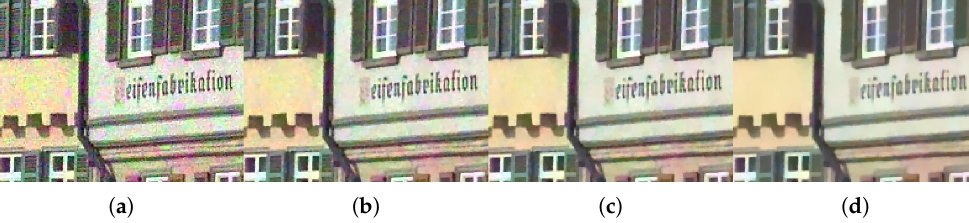
Figure 9. Influence of regularization parameter λ 1 for test image House for crosstalk degradation 2 (crosstalk kernel with σ g = 0.6 and noise with σ n = 0.04): ( a ) λ 1 = 0.01, ( b ) λ 1 = 0.03, ( c ) λ 1 = 0.05, and ( d ) λ 1 =